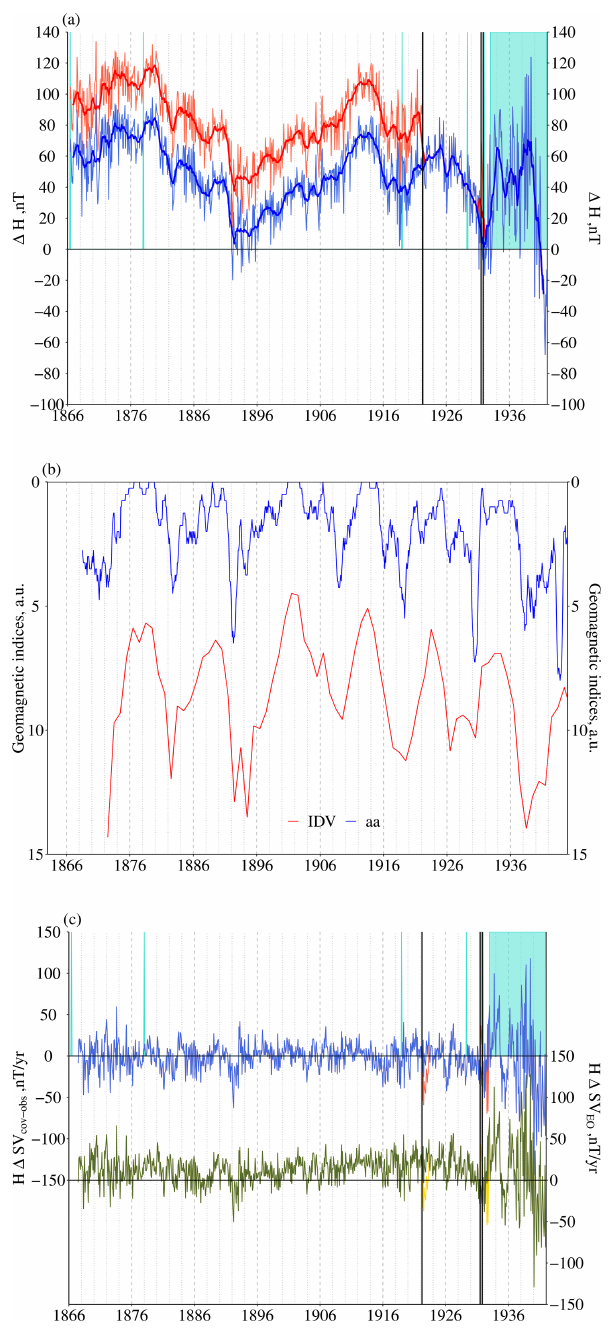
Figure 2. (a) Original (red) and corrected (blue) COI (cid:49)H series for the C–AdB (Cumeada and Alto da Baleia) period of measurements: 1866–1941. Thin lines are data, and thick lines are the moving av- erage with a 12-month window. (b) Variations of the geomagnetic indices aa (monthly data, blue) and IDV (annual data, red). Please note the reversed y axis. (c) Original (red) and corrected (blue) (cid:49) SV COV − OBS series for H ; original (yellow) and corrected (green) (cid:49) SV EO series for H . Cyan vertical lines and rectangles mark pos- sible HBs which are not corrected (see details in the text); black vertical lines mark dates of the corrected